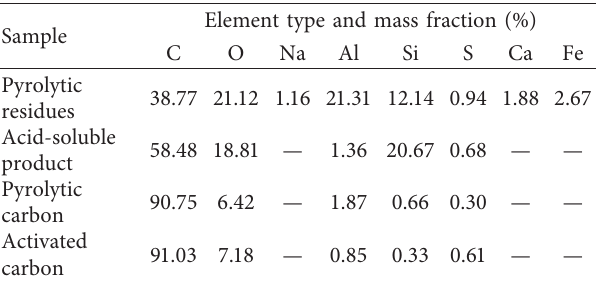
Table 4: Elemental analysis of pyrolytic residues at different stages.